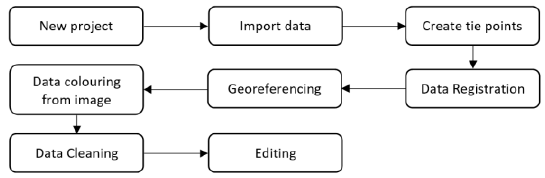
Figure 27. Data processing steps using ScanMaster